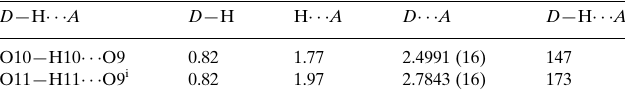
Hydrogen-bond geometry (A˚ , (cid:3)